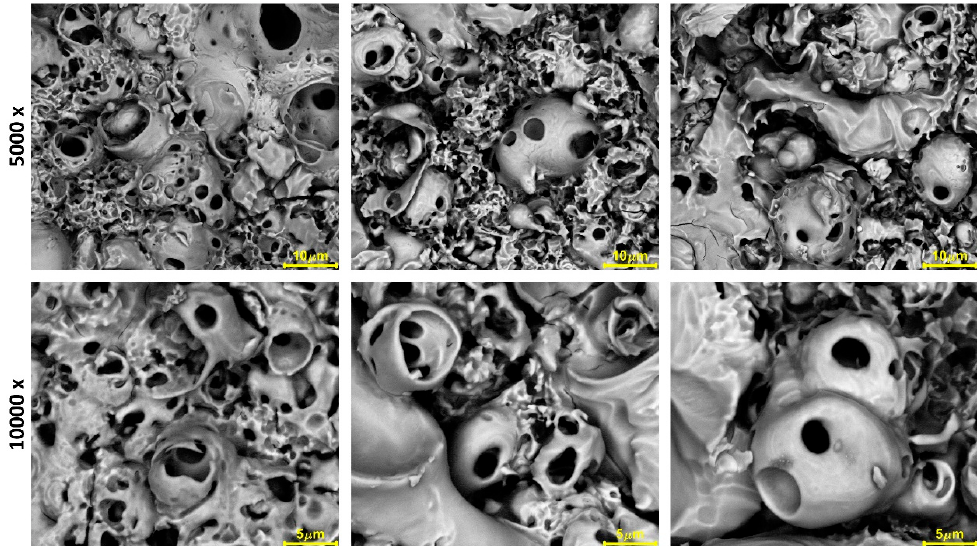
Figure 9. SEM micrographs of samples surfaces after PEO processing obtained in electrolytes composed of 250 g/L Mg(NO 3 ) 2 ·6H 2 O and 250 g/L Zn(NO 3 ) 2 ·6H 2 O in H 3 PO 4 at three voltages, 500 V, 575 V and 650 V. Magnifications 500, 1000, 5000, and 10,000 times.